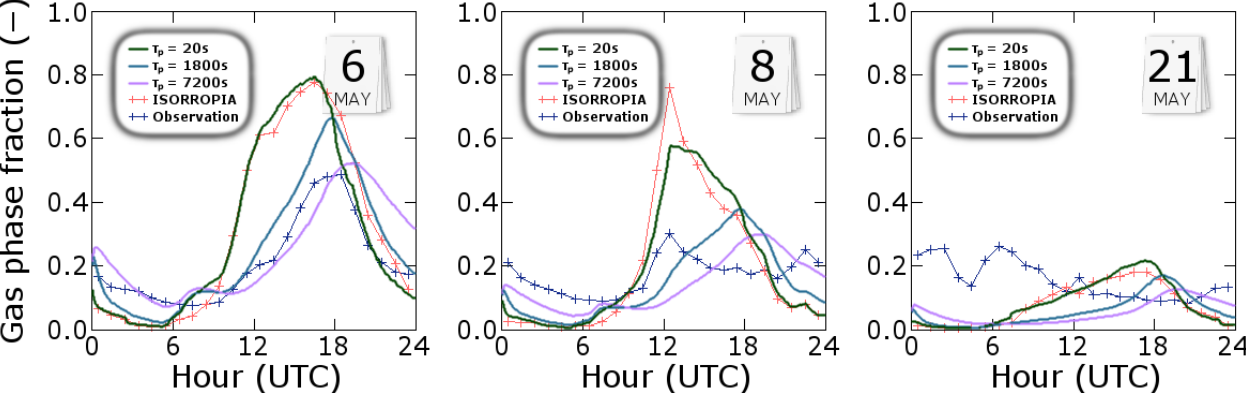
Fig. 5. Partitioning of nitrate modelled by the column model with different timescales of partitioning ( τ p ), the ISORROPIA-only simulation and the observation for 6 May (left), 8 May (middle) and 21 May